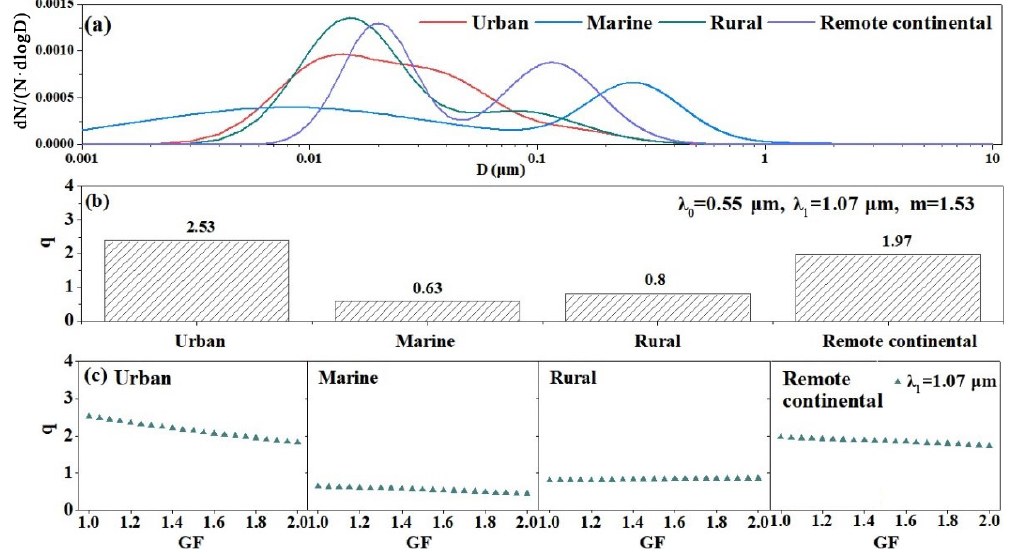
Figure 2. Critical data used or obtained for the urban, marine, rural, and remote continental groups in the simulation calibration. Panel (a) shows the probability distribution function of aerosol particle size. Panel (b) shows the values of the Ångström exponent ( q ) obtained in the simulation calibration. Panel (c) shows the relationship between q and the hygroscopic growth factor